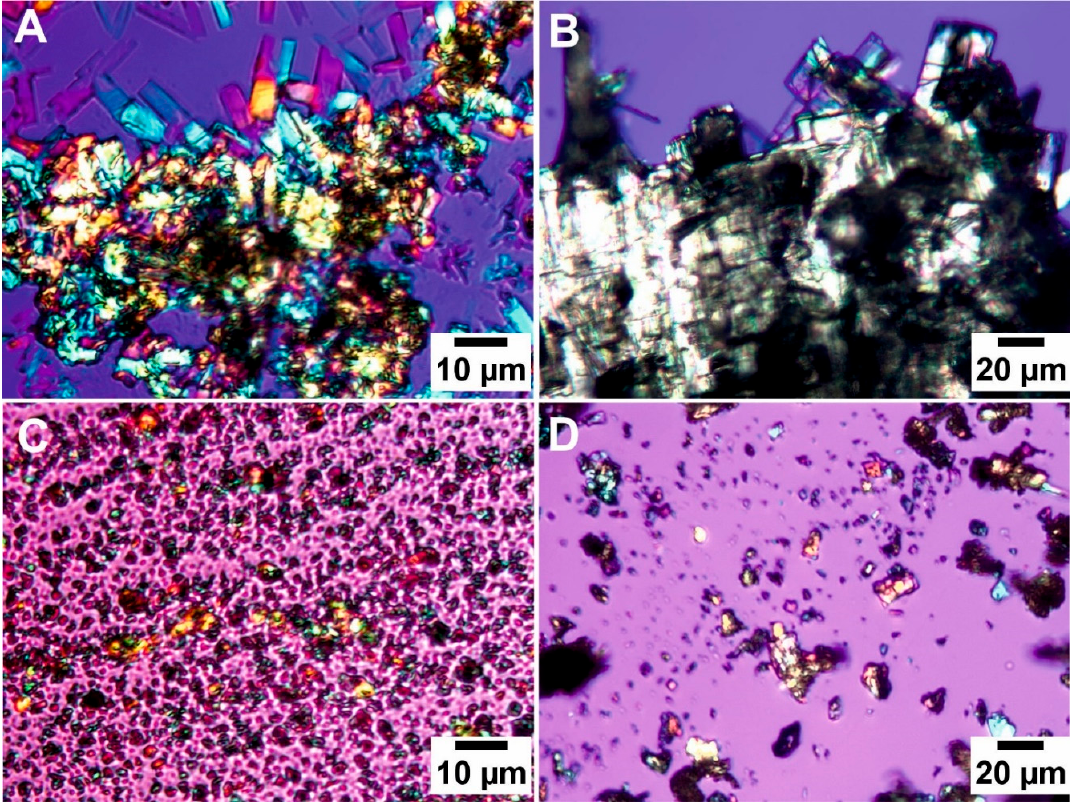
Figure 2. Images of zolpidem tartrate taken using polarizing light microscopy. ( A ) Salt obtained by crystalizing from methanol (Method A): prior to analysis crystals were dissolved in drop of methanol which was evaporated on microscope plate; ( B ) crystals obtained in Method A placed directly on microscope plate without recrystallization; ( C ) salt obtained by adding Et 2 O (Method C): prior to analysis, the crystals were dissolved in drop of methanol, which was evaporated on a microscope plate; ( D ) crystals obtained in Method C placed directly on a microscope plate, without recrystallization. Images were taken using RT series camera (Opta-Tech, Warsaw, Poland) and polarized light microscope Hund Wetzlar type H600/12 (Helmut Hund GmbH, Wetzlar, Germany).